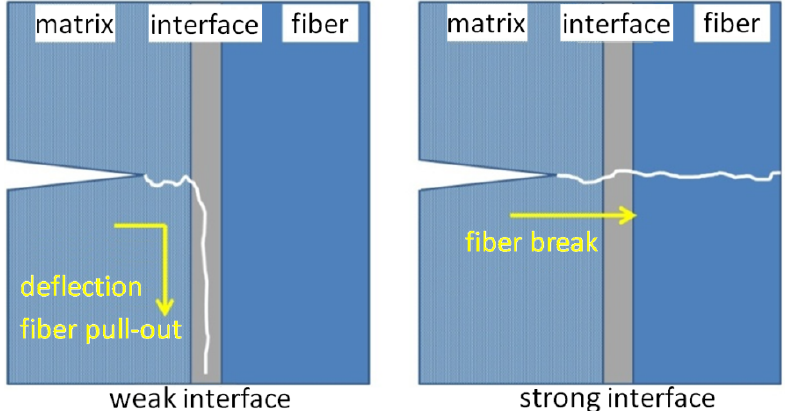
Figure 7. Schematic illustration of influence of interface strength on fracture mode of SiC–SiC.